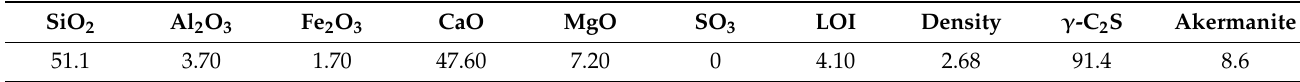
Table 2. Chemical composition of synthetic γ -C 2 S.